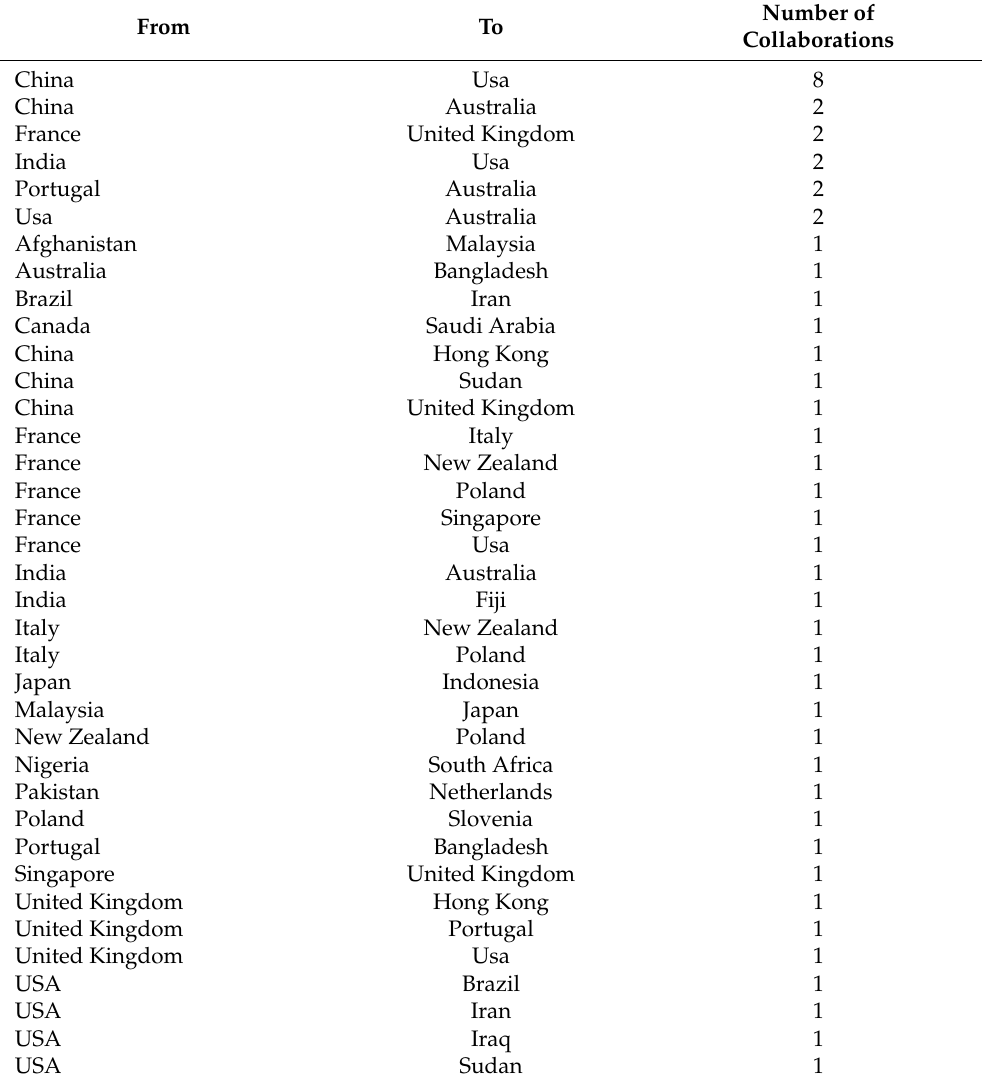
Table 5. Countries’ scientific collaboration on geosyinthetics research entrenched with managerial implications, as considered in this study.